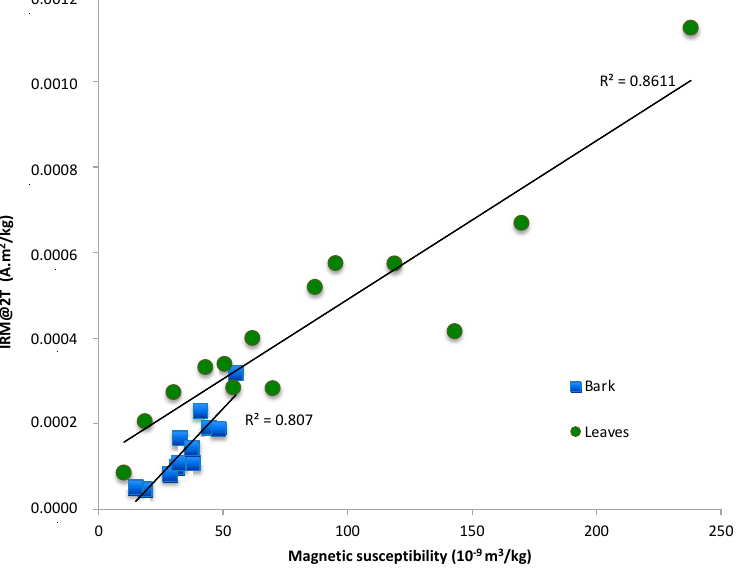
Figure 4. Saturation isothermal remanent magnetization (SIRM) as a function of mass magnetic susceptibility depicting correlations for both leaves (green dots) and bark (blue